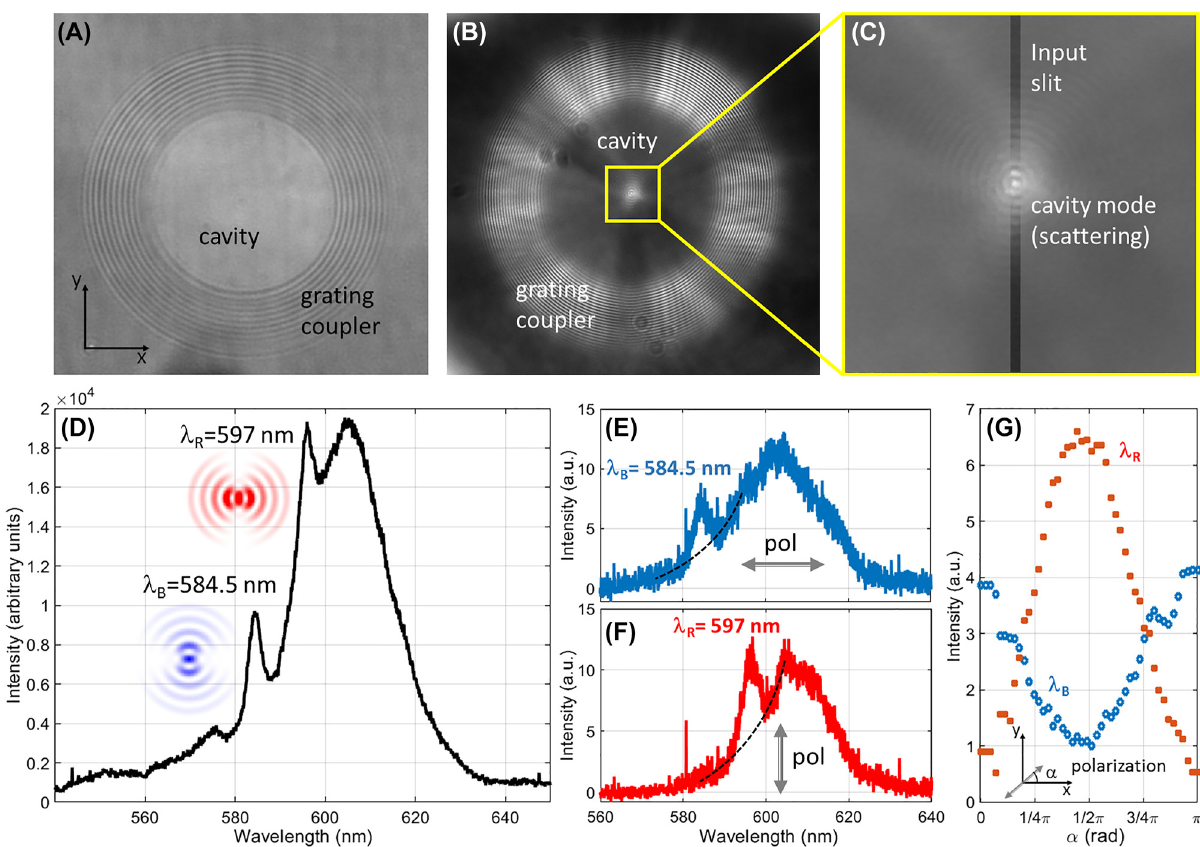
Figure 4: BSW cavity modes. (A) Bright-field, transmission image of the cavity surrounded by the grating coupler; (B) high-frequency image of the structure, after the Fourier filtering by means of the beam-blocker on the collection path; (C) magnified image of the scattering pattern from the cavity centre. The central spot is selectively fed into the monochromator input slit, as sketched by the shadowed boxes; (D) scattering spectrum collected from the cavity centre. Two peaks appear at 584.5 nm and 597 nm, revealing corresponding cavity modes. Polarization-filtered spectra: (E) x -oriented polarization, (F) y -oriented polarization; (G) modulation of the peak intensities (background-subtracted) at 584.5 nm and 597 nm for different orientation angles 𝛼 of the polarizer with respect to the x